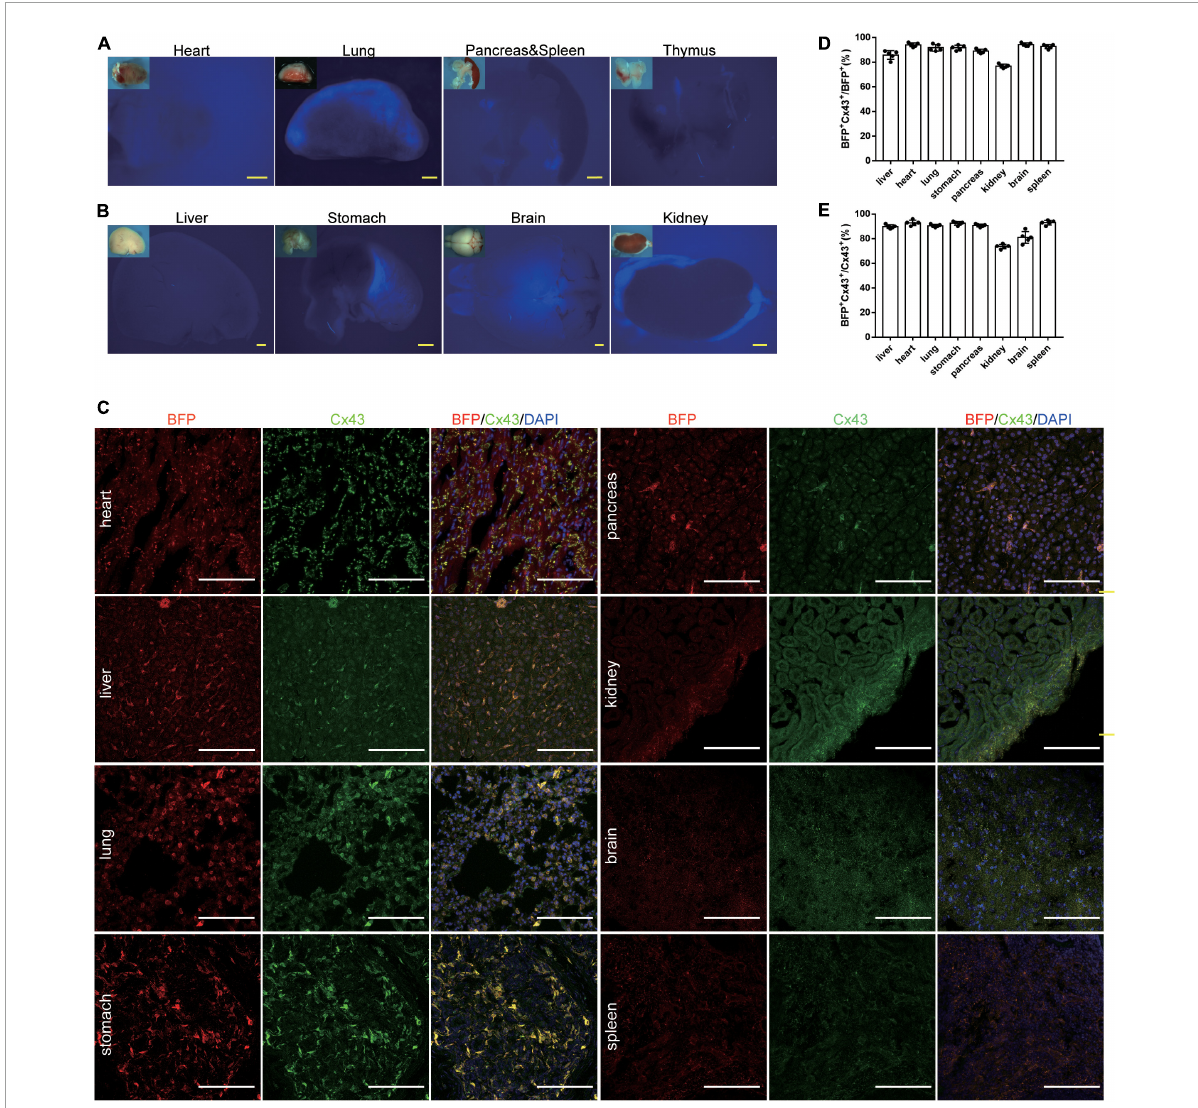
FIGURE3 Generation and Characterization of Cx43-BFP-GFP/ + reporter line. (A,B) Whole-mount bright field and epifluorescence images of visceral organs from 6-weeks Cx43-BFP-GFP/ + mice; (C) immunostaining for BFP and Cx43 on heart, lung, brain, stomach, kidney, liver, spleen, and pancreas sections. The high magnification images of organs in areas labeled with the square dotted frame, respectively; (D) quantification of the labeling efficiency by the percentage of BFP + Cx43 + in BFP + cells. Data are the mean ± SD; n = 5 mice per group; (E) quantification of the labeling specificity by the percentage of BFP + Cx43 + in Cx43 + cells. Data are the mean ± SD; n = 5 images per group. Yellow scale bar = 1 mm, white scale bar = 100 µ